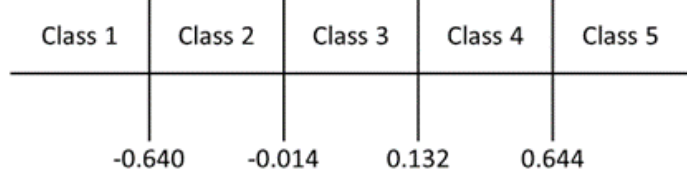
Figure 3. The range of risk value and its quartile range.